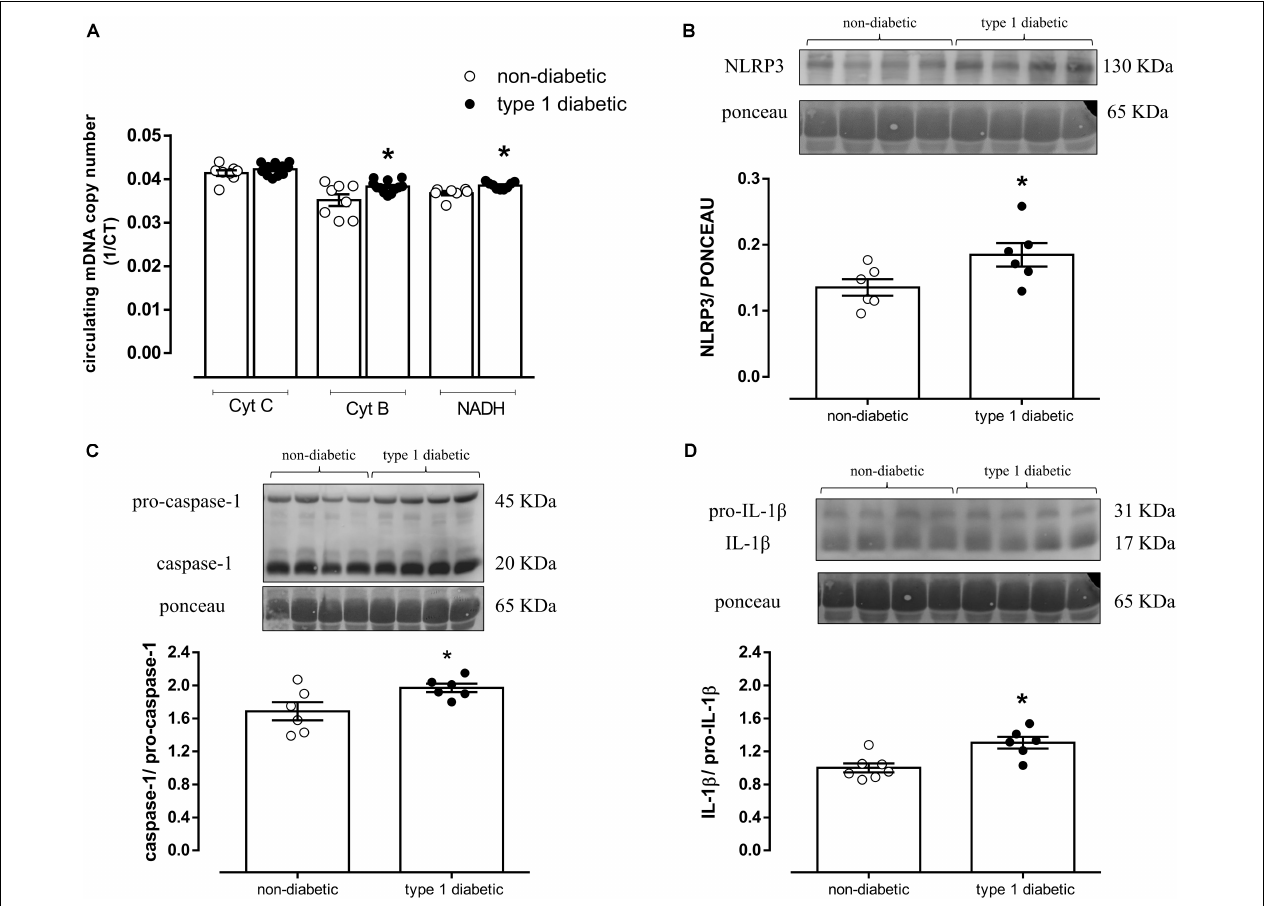
FIGURE 7 | (A) Quantification of mitochondrial DNA genes cytochrome C (Cyt C), cytochrome B (Cyt B) and NADH dehydrogenase (NADH). On top, representative images of western blot and, at the bottom, densitometric analysis of the expression of (B) NLRP3, (C) caspase-1 and pro-caspase-1, and (D) IL-1 β and pro-IL-1 β in the serum from non-diabetic subjects (white circles) and patients with type 1 diabetes (black circles). Each column represents the mean ± SEM. ∗ P < 0.05 vs. non-diabetic. N = 5–12, Student’s t -test (A–D)